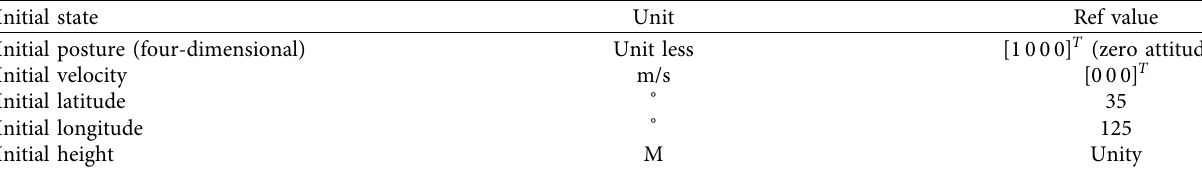
Table 4: Initial conditions of SINS navigation simulation.